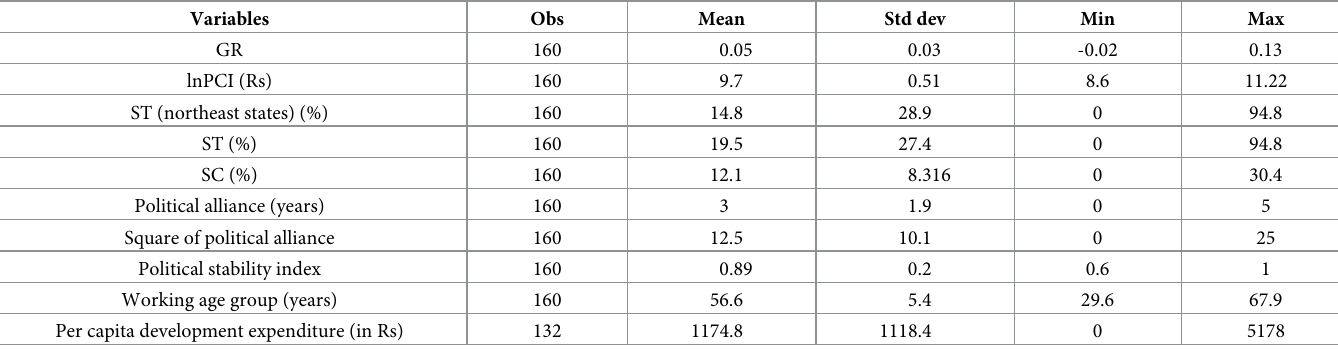
Table 1. Descriptive statistics of variables used in the analysis.